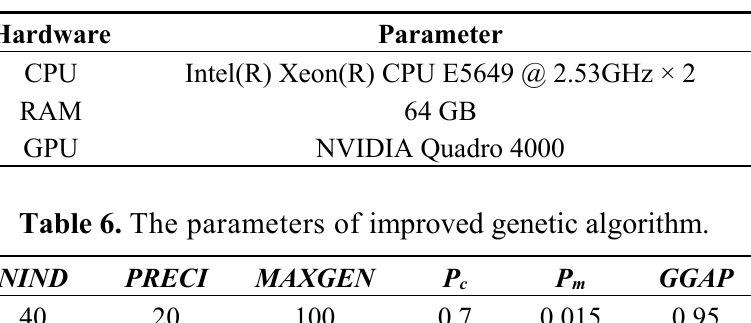
Figure 16. The schematic diagram of novel optimization method. Table 5. The parameters of hardware platform.